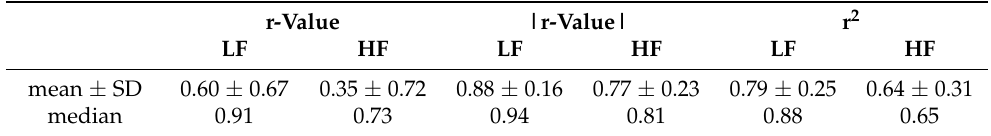
Table 6. The correlation coefficient and coefficient of determination in different SVV bandwidth (low frequency [LF] and high frequency